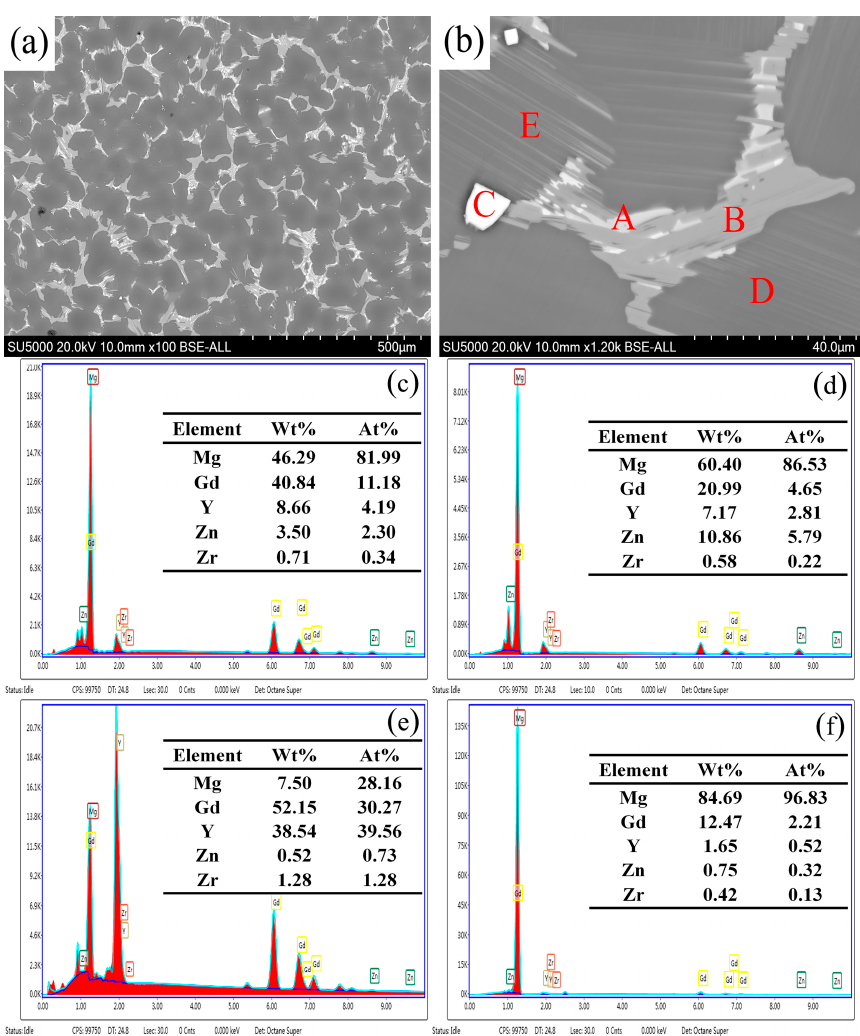
Figure 4. The microstructure of the as-cast Mg-12.0Gd-4.5Y-2Zn-0.4Zr alloy: ( a ) backscattered electron-scanning electron microscopy (BSE-SEM); ( b ) a magnified image of ( a ); and ( c – f ) the corresponding energy-dispersive X-ray spectrometer (EDS) results of the phases marked A, B, C, and D, respectively.